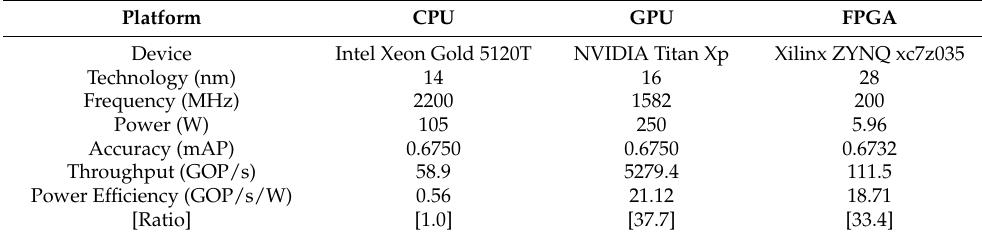
Table 3. The evaluation results on the Central Processing Unit (CPU), the Graphic Processing Unit (GPU), and the proposed architecture on the field-programmable gate array